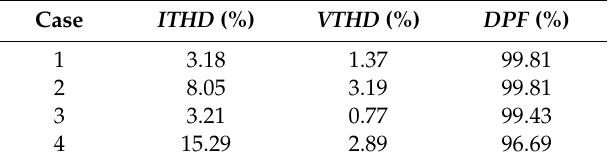
Table 4. Harmonic distortions level and DPF after compensation for all cases under study.